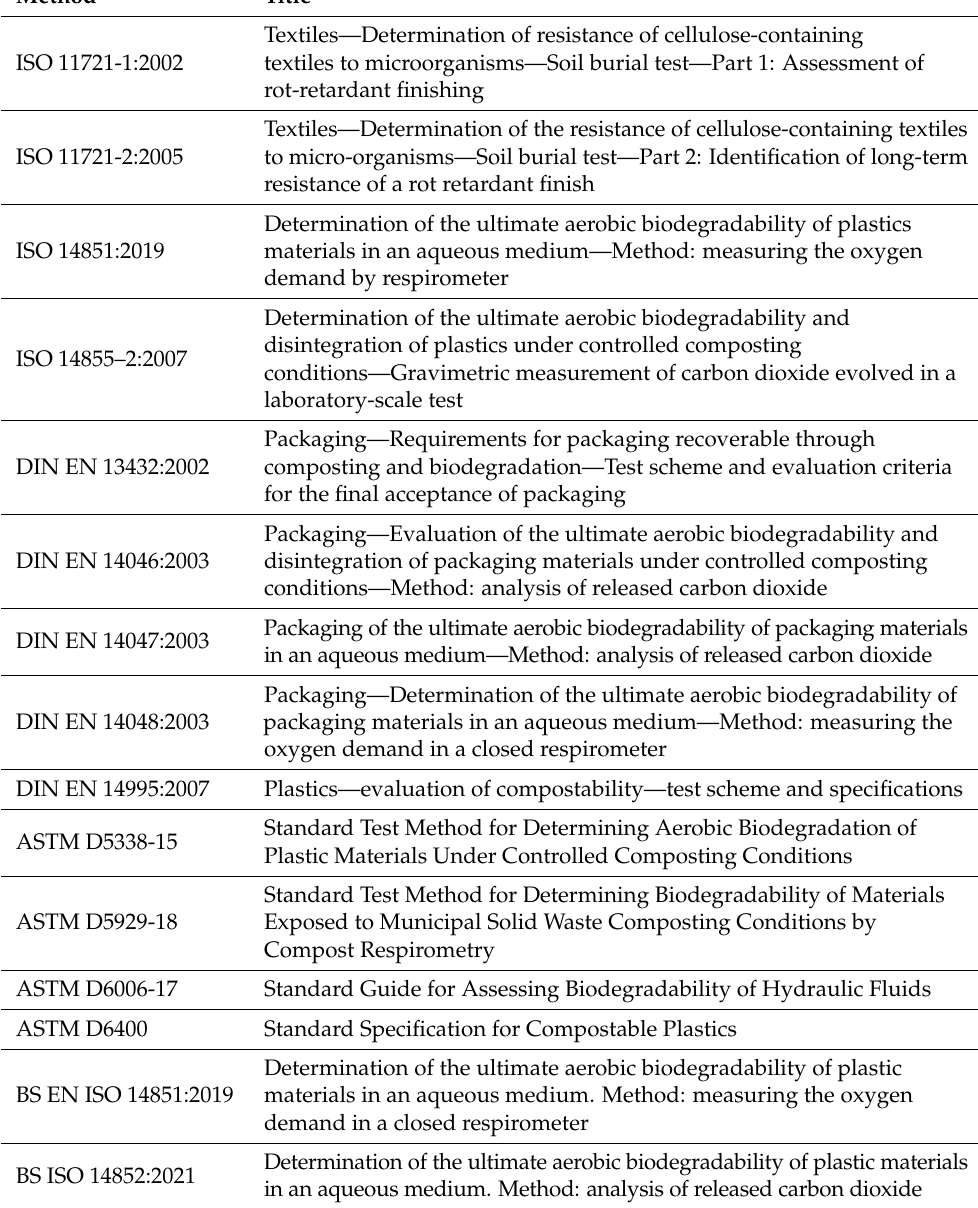
Table 3. List of selected biodegradation